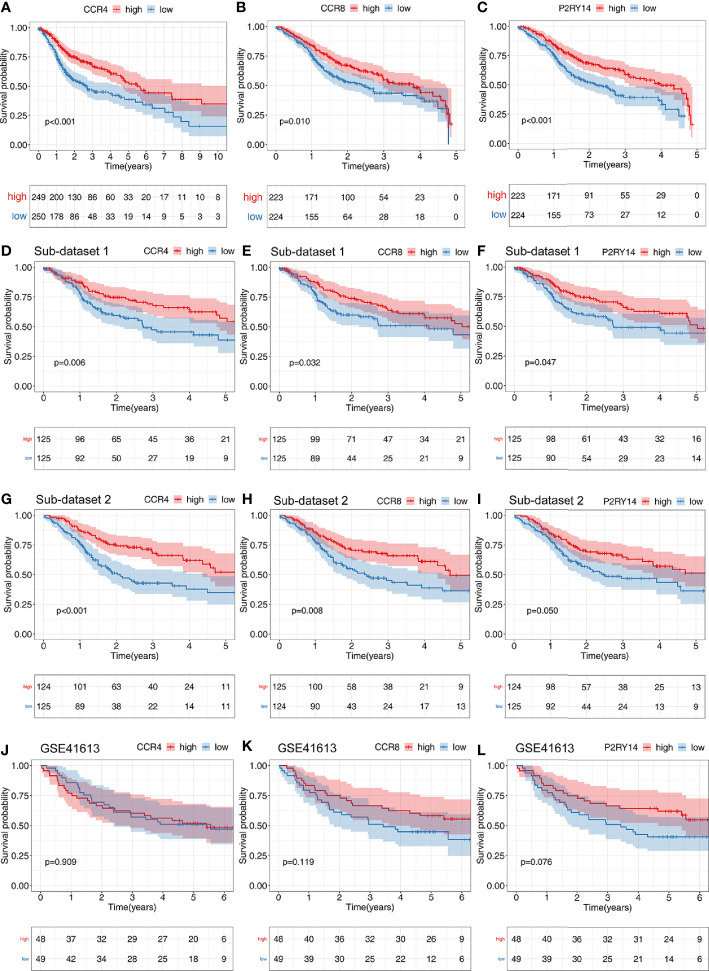
Results of survival analyses of hub genes. The expression of CCR4
(A), CCR8
(B), and P2RY14
(C) were all significantly correlated with patient prognosis in the TCGA data set, and the higher the level of gene expression, the better the patient’s prognosis. (D–I) Survival analysis of two randomly distributed subsets showed results consistent with the original data set, with the expression of all of the three hub genes significantly correlated with survival. (J–L) Survival analysis was performed on another validation data set GSE41613.